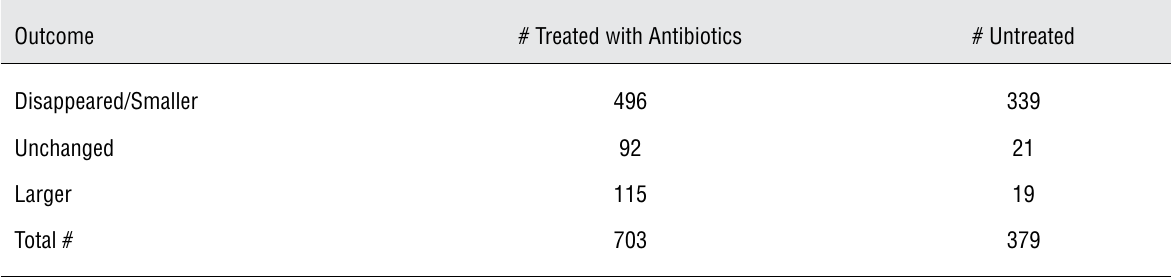
Table 4 - Outcome of small Renal Masses in 703 Patients Treated with Antibiotics for Inflammatory. Conditions of the Gastrointestinal or Biliary Tract and Pancreas versus 339 untreated Patients. Outcome # Treated with